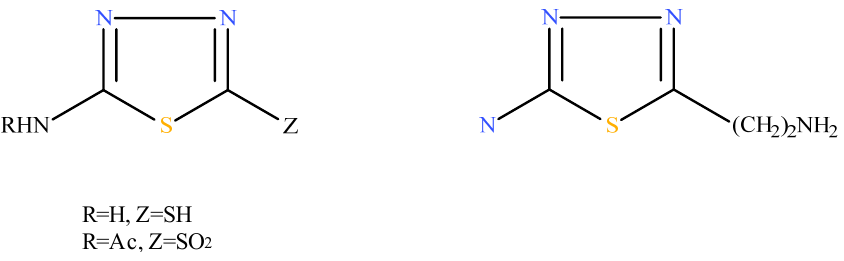
Figure 1. Representative structures of some potent 1,3,4-thiadiazoles.